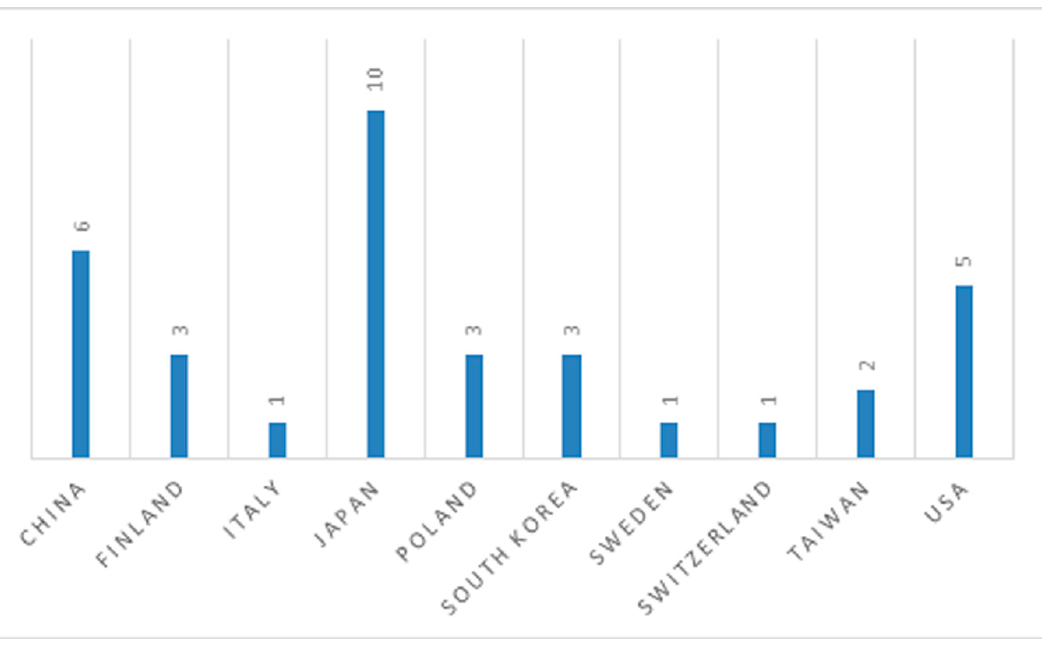
Figure 2. Geographical distribution of the studies.